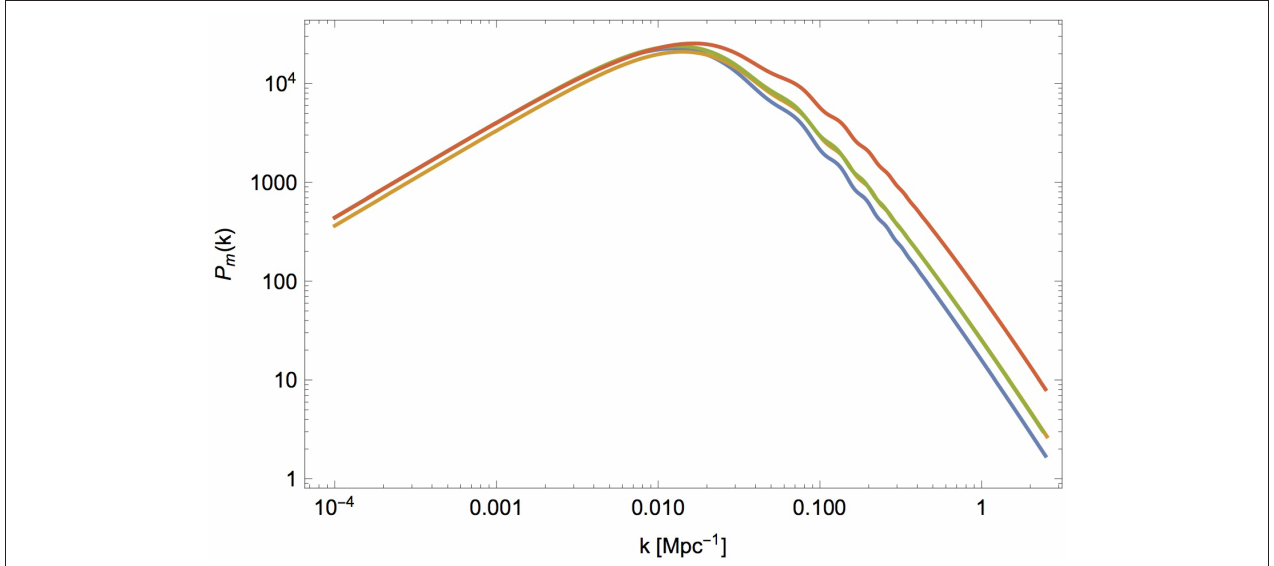
FIGURE 2 | Total matter power spectrum P m for the same models shown in Figure 1 .